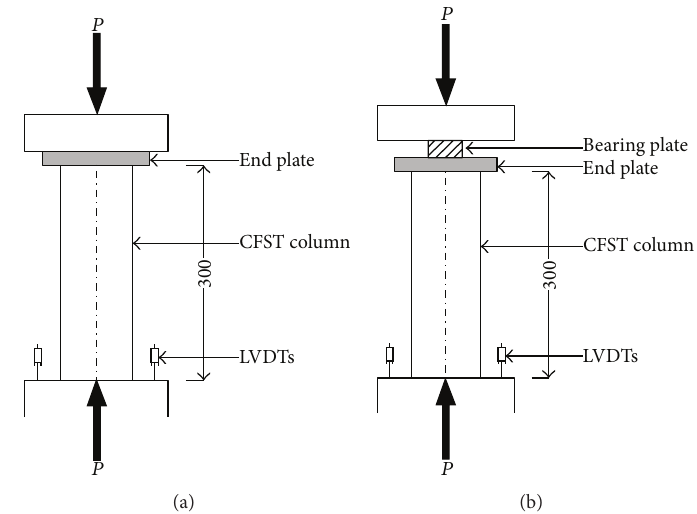
Figure 2: Full and partial compression testing setup.